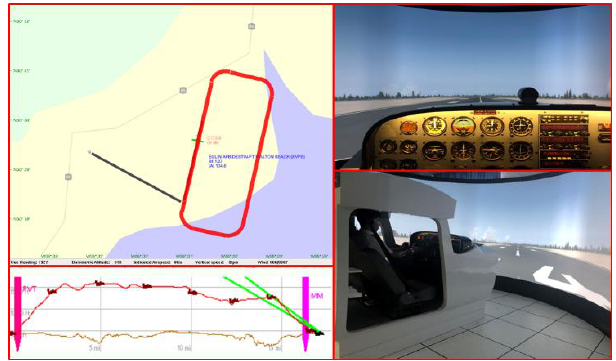
Figure 7. Schematic diagram of the pilot completing the airfield traffic pattern.